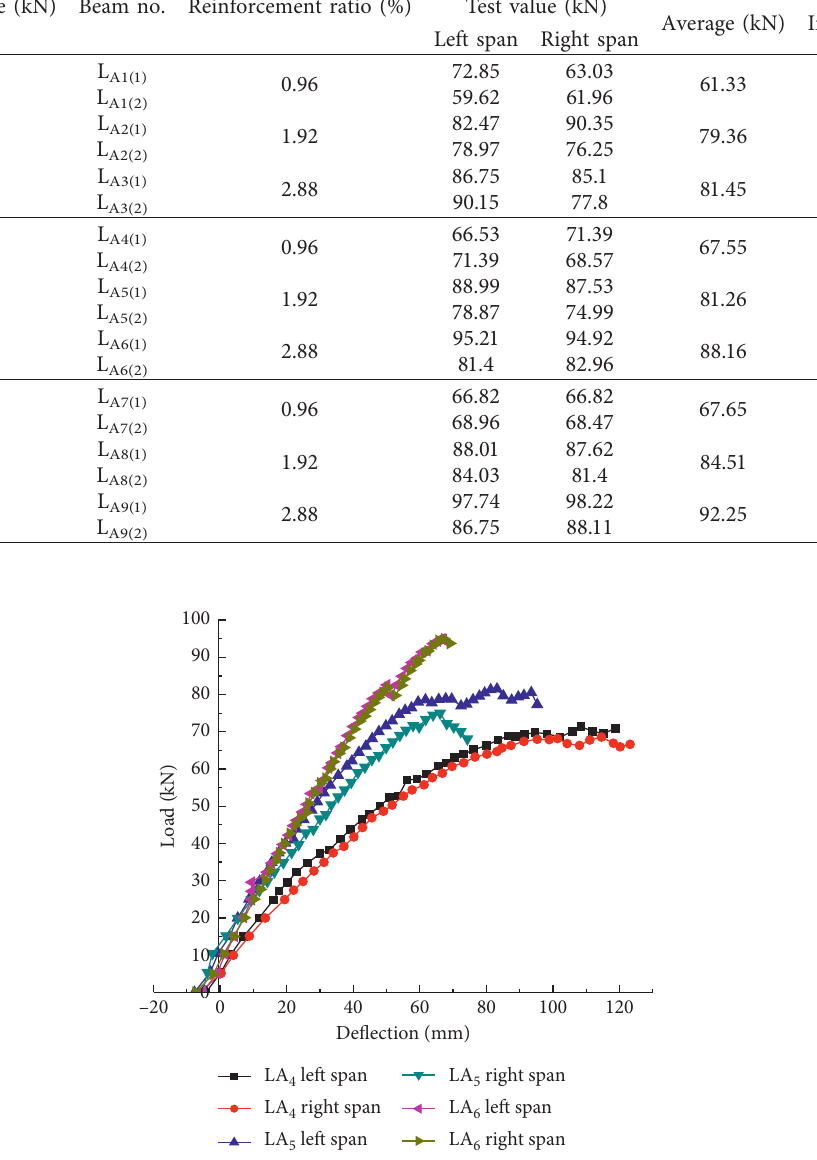
Figure 10: Load-deflection curves of beams with different numbers of steel bars under a load of